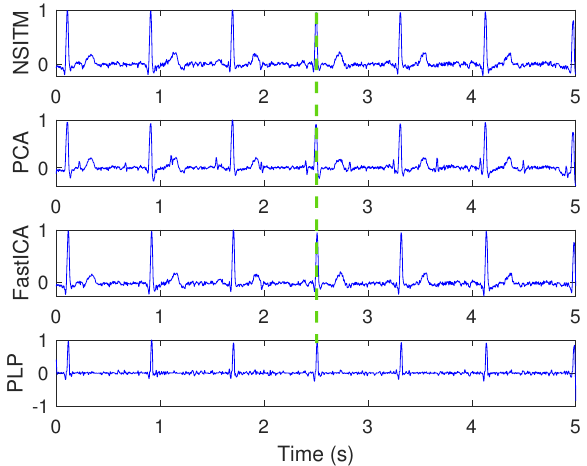
Figure 11. Extracted MECG signals from ECG signals in Figure 9, using NSITM, PCA, and FastICA, and PLP. Only MECG R peaks exist. For illustration, only one marked MECG peak is shown by green dashed lines. The y -axis labels refer to the names of the algorithms used for extracting the MECG signals. The data used are from the Physionet Challenge 2013 data set a, file a15.